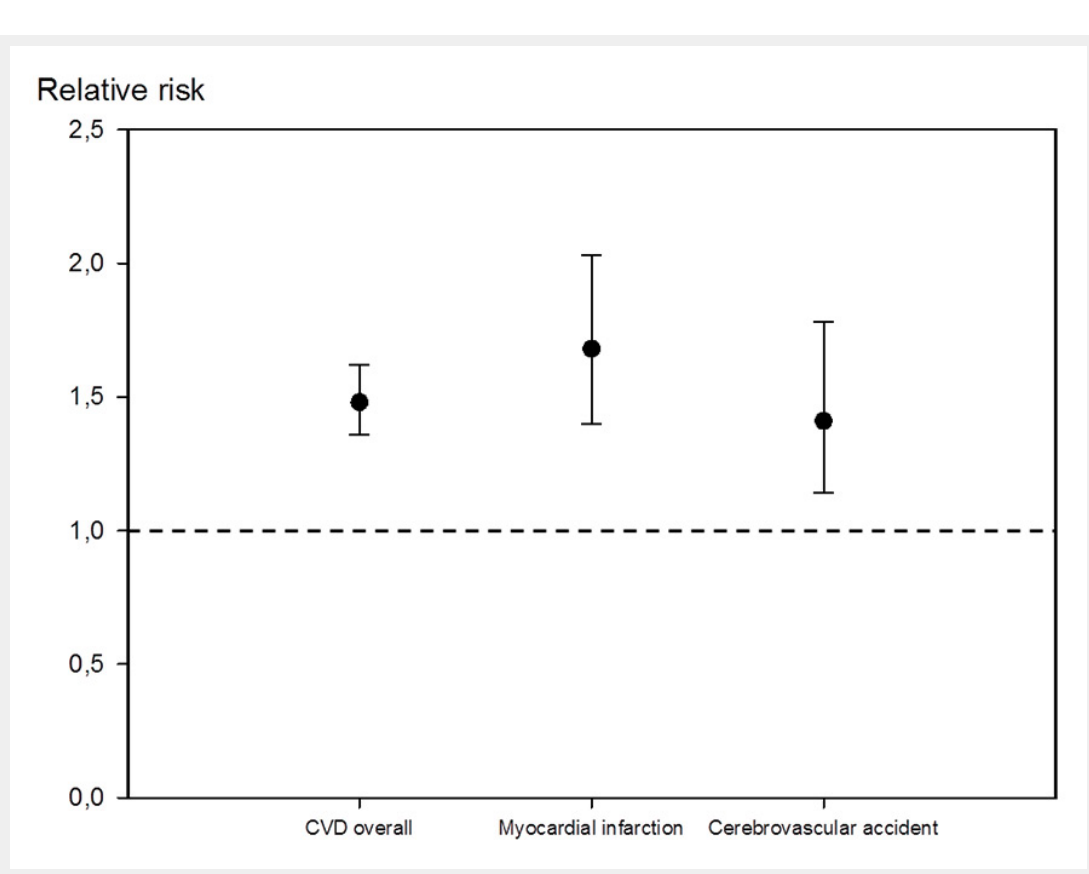
Figure 1 Pooled relative risks with 95% confidence intervals of cardiovascular disease (CVD) events in patients with rheumatoid arthritis compared to the background population. Based on data from a meta-analysis of 41490 patients in 14 observational studies (Avina-Zubieta et al. Ann Rheum Dis. 2012;71(9):1524–9